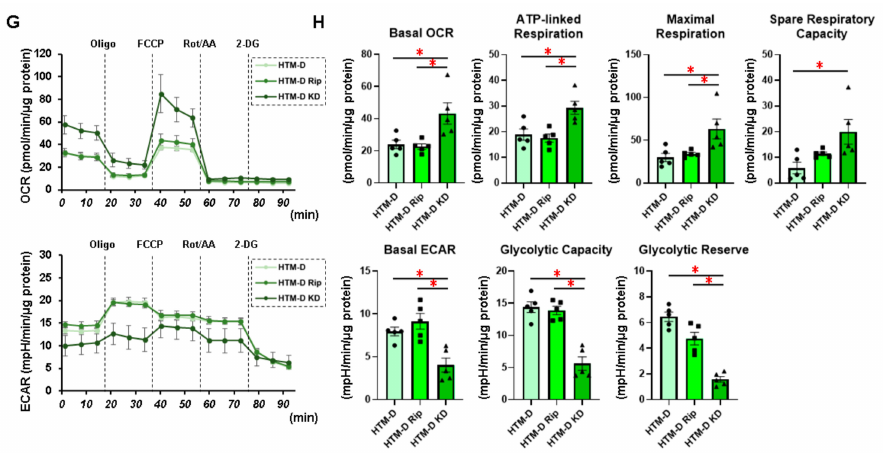
Figure 1. Measurement of mitochondrial and glycolytic functions of TGF- β 2- or DEX-treated or untreated 2D cultured HTM cells in the absence or presence of ROCK inhibitors (ROCK-is).Under the following four conditions: (1) 2D cultured HTM cells (HTM) and those treated with 5